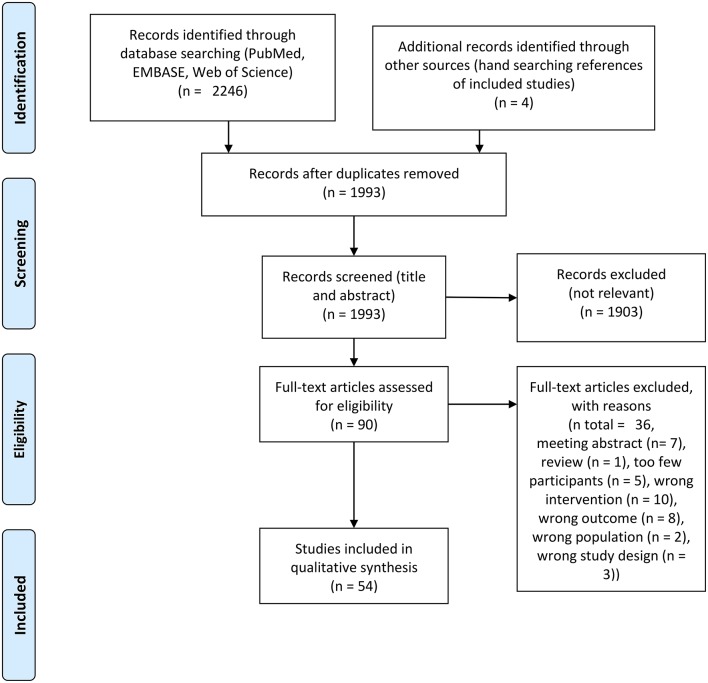
PRISMA flow chart of included studies.